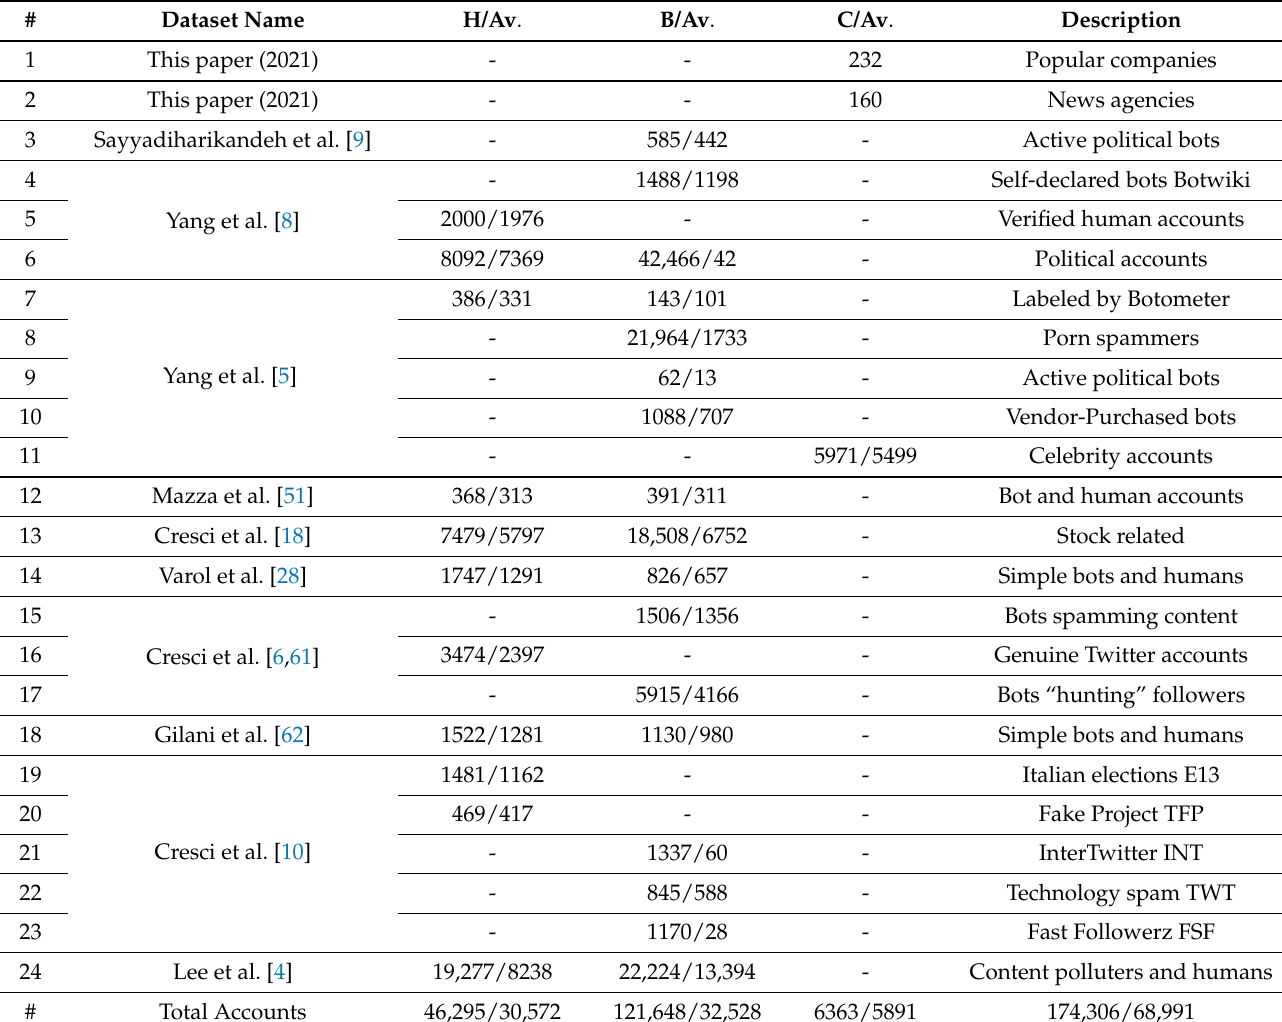
Table 1. Outline of collected datasets. Columns H , B and C refer to Humans, Bots and Cyborgs, respectively. The actual data are those presented as Av . Only 40% of the total shared labeled accounts are still available in